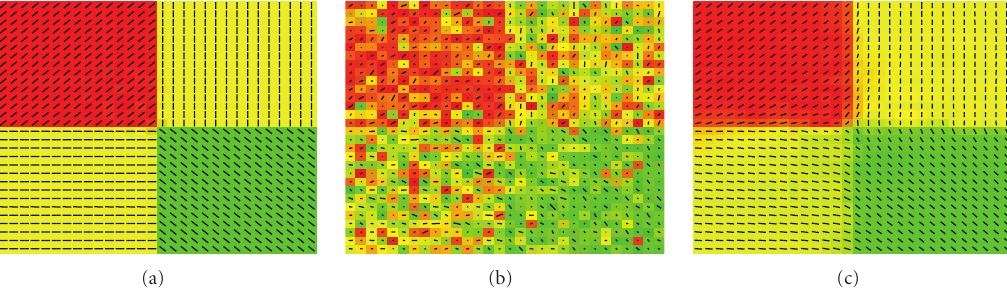
Figure 2: A synthetically produced purely anisotropic tensor field with four distinct regions is degraded with normally distributed noise. The noisy field is then processed with our proposed method: (a) the clean vector field D 0 ; (b) the noisy field ˆ D ; (c) the recovered field D